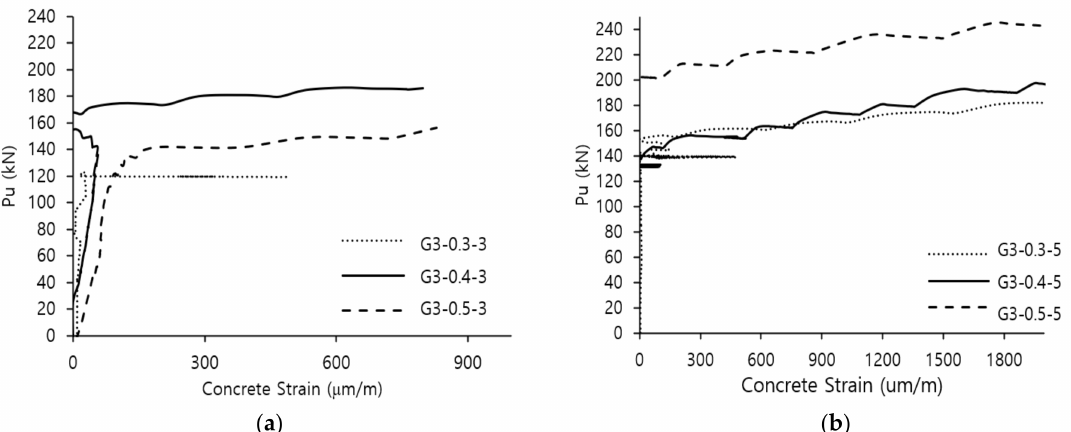
Figure 8. Relation between ultimate load and strains in concrete web for different flange thicknesses— at flange width ratios of 3 and 5. ( a ) Specimens with ρ b = 3; ( b ) specimens with ρ b = 5.